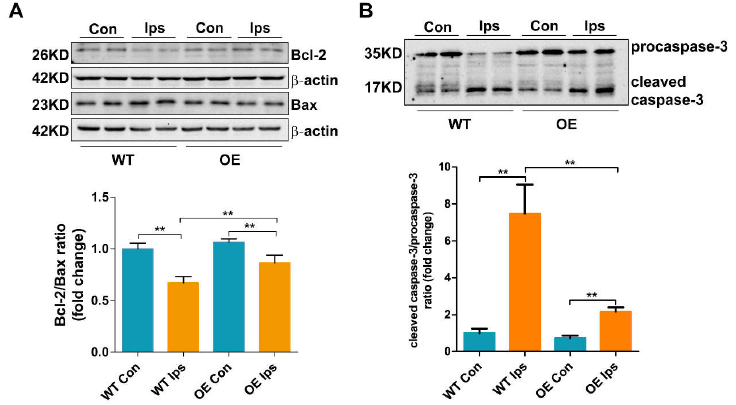
Figure 3. Overexpression of FtMt abrogates endothelial cell apoptosis after cerebral I/R. Western blot and densitometric analyses of ( A ) the ratio of Bcl-2 to Bax, ( B ) the ratio of cleaved caspase-3 to procaspase-3 ( n = 4). The data are expressed relative to the mean value in the WT Con group ( n = 4). The results are presented as the mean SEM. ** p < 0.01.